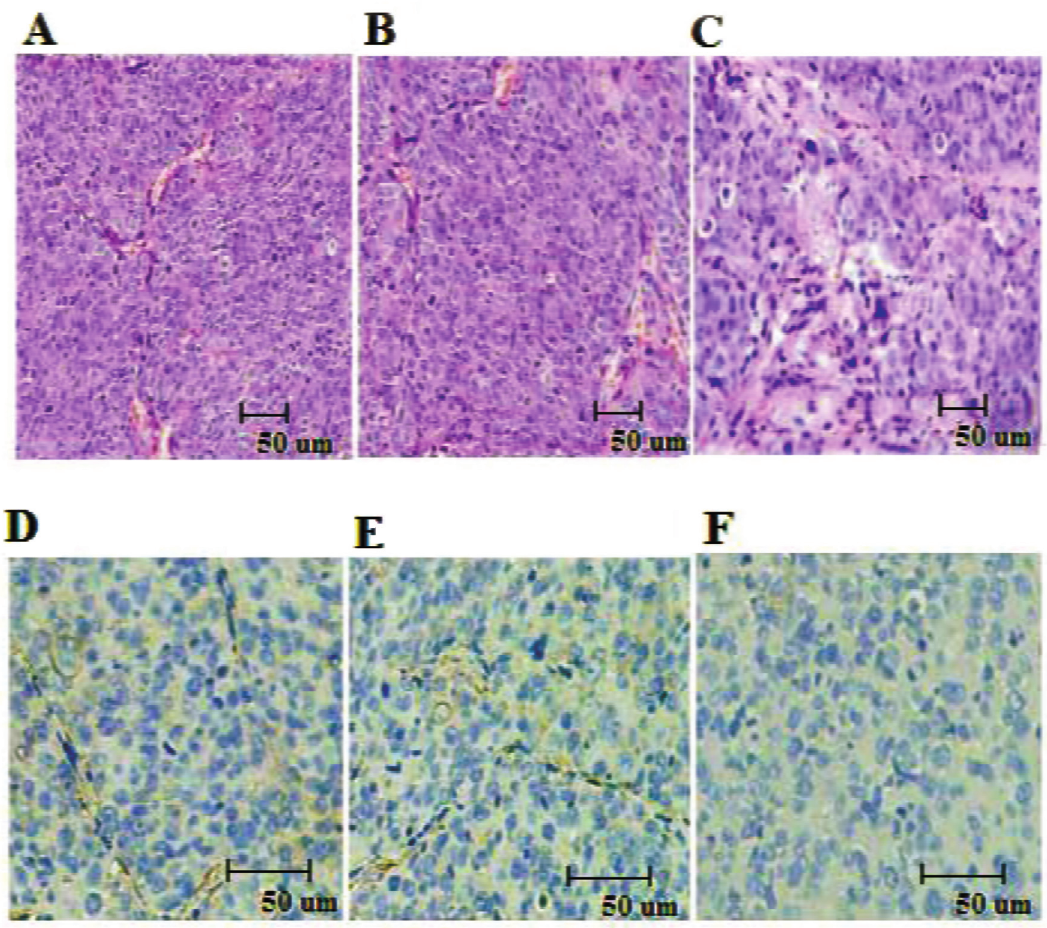
Figure 5. HE staining and CD34 immunohistochemical analysis. A , HE staining of the HT-29; B , HT-29-GFP; C , HT-29- shSTAT3 groups. In A and B , there were many heterokaryocytes and blood vessels. However, in C there were few blood vessels. D , E , and F , CD34 immunohistochemical analysis in the three groups, respectively. In D and E , microvessel density was higher than in F . Magnification bars: 50